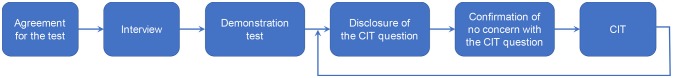
Flowchart of the polygraph in Japan.